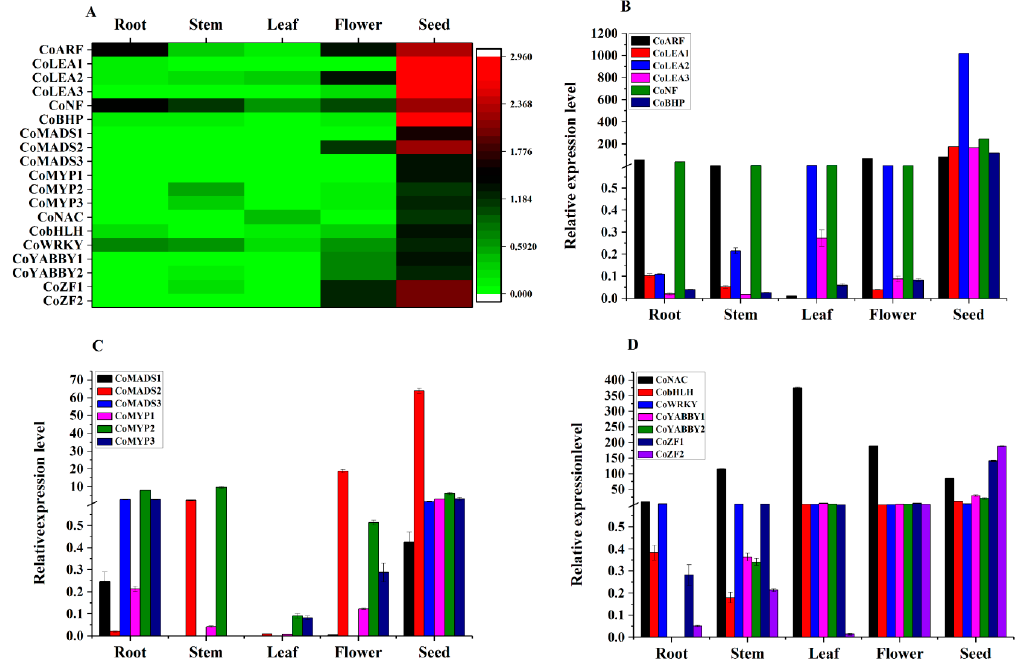
Figure 8. Transcriptome and following qRT ‐ PCR analysis of the TFs in different organs including seed, root, stem, leaf and flower, respectively. ( A ) Heat map depicting of seed ‐ specific TFs. ( B – D ) qRT ‐ PCR analysis of seed ‐ specific TFs.